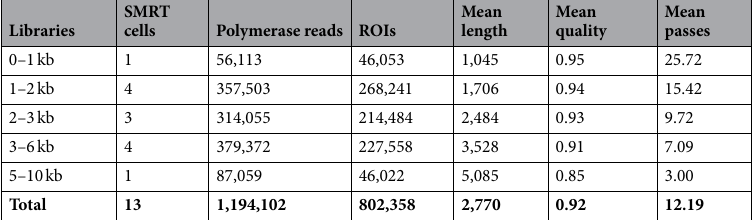
Table 1. PacBio libraries, SMRT cells and sequencing results.